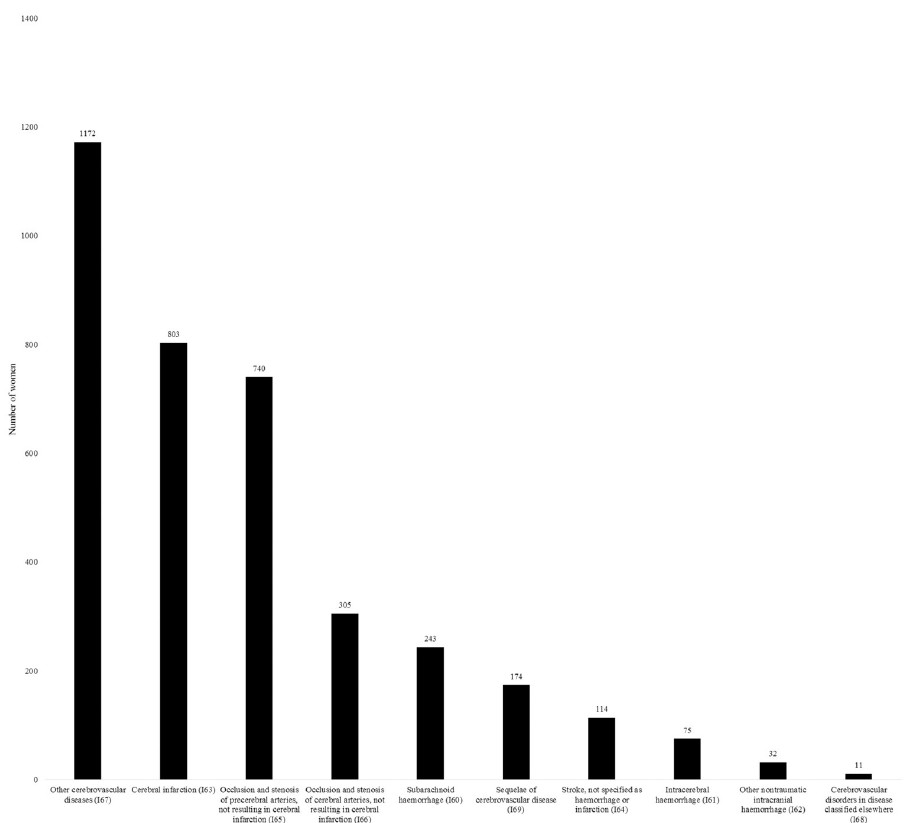
Fig 1. Diagnoses of “Cerebrovascular diseases” (I-numerical codes) received during 2004–2016 prior to first pregnancy within the study period.